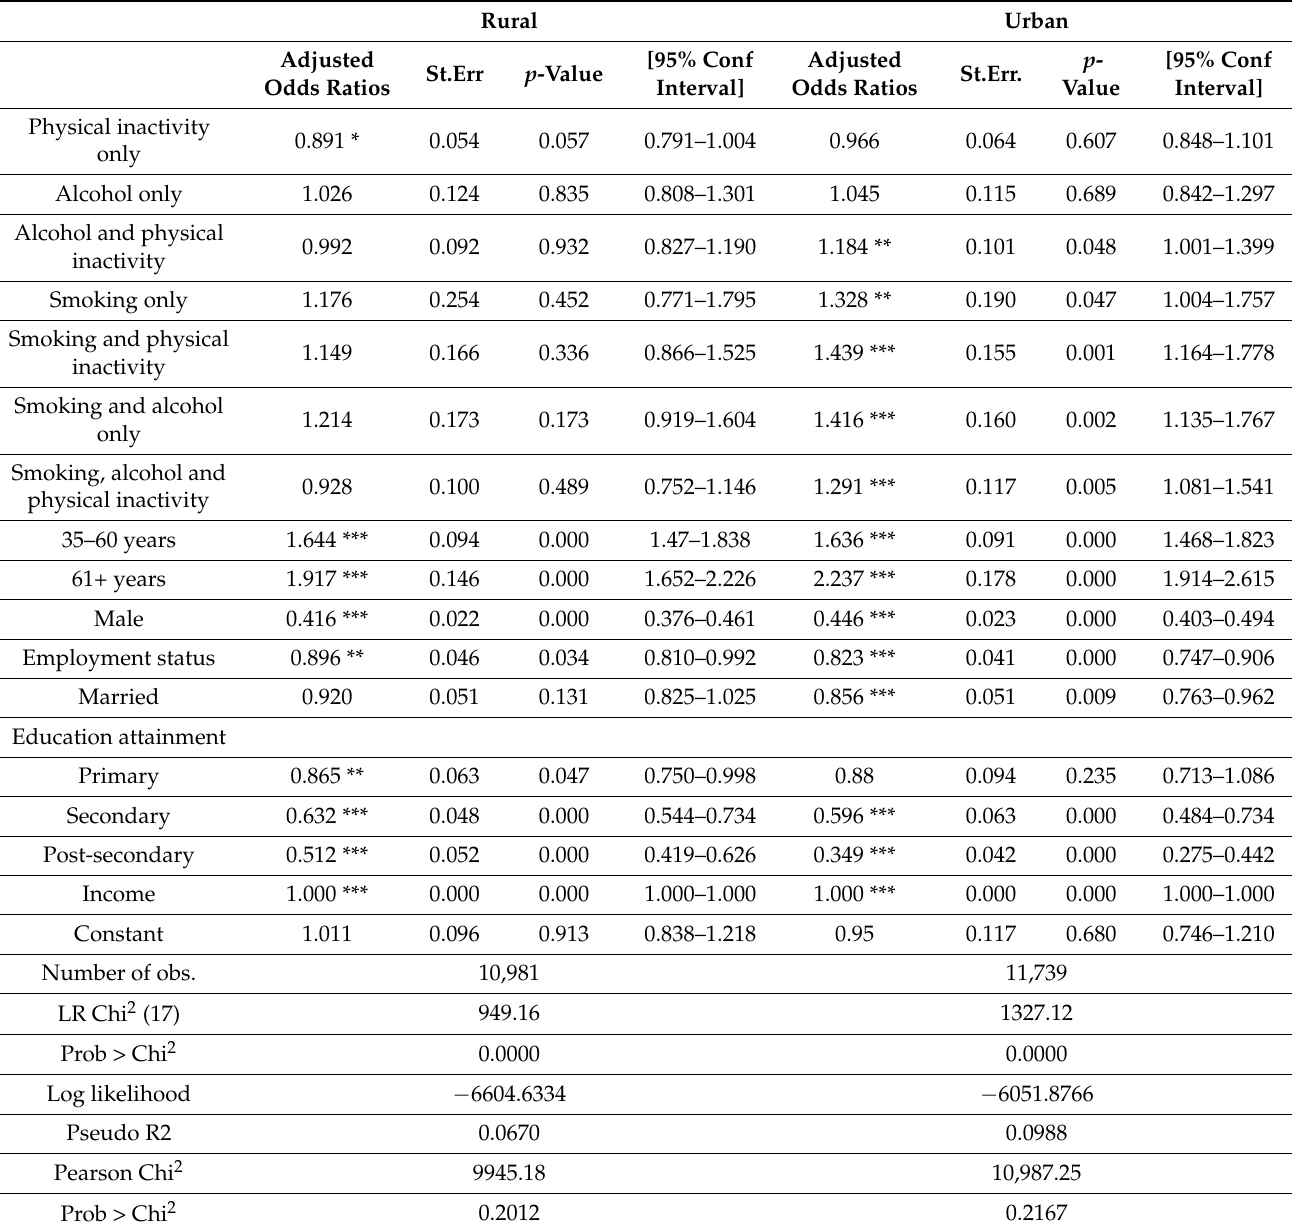
Table 6. Multivariate logistic regression result on effect of lifestyle risk factors on public PHC: By geographical disaggregation.